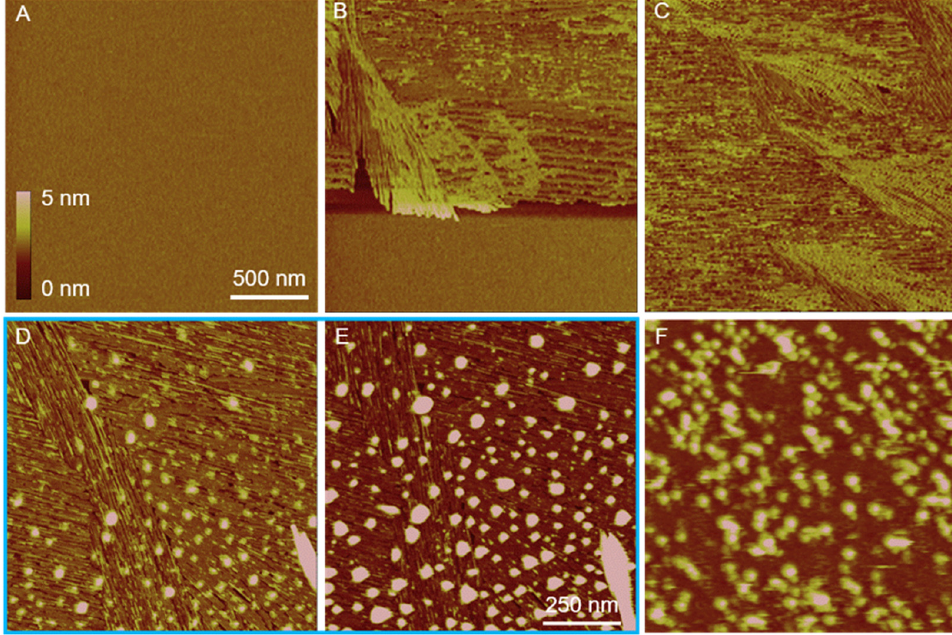
Figure 2. Interfacial BNB production and characterization via in situ AFM. AFM images of ( A ) bare mica; ( B , C ) short peptide GAV-9 self-assembled thin film on mica. ( D , E ) After the addition of ice-melting water, obvious nanobubbles rapidly absorbed onto the peptide self-assembled film. ( F ) After 12 min, the nanobubbles started to form an isolated layer between peptide film and bulk water until hard imaging via AFM. The height bar and scale bar are fit for all figures except ( D , E ), which are boxed in blue.